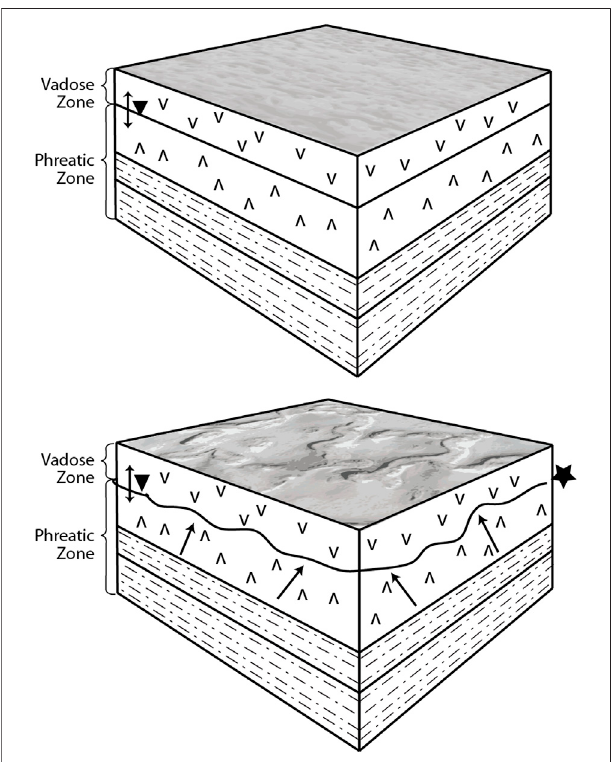
FIGURE 9 | Drawing of proposed sequence of ridge formation. The upper sketch is the starting point for the evaporitic-sediment package. The inferredbasallakebedsbecomemoresalt-rich(calcite,gypsumandhalite(^s) with increasing evaporation. The gypsum surface beds (^s) form during freshening events. Thelower sketch shows asomewhat wetter time when the Ca-Na-Cl-SO 4 mixture (highlighted by + ) precipitates minerals that force the surface upward (arrows) forming expansion ridges in pseudo polygonal patterns. Modi fi ed from Warren